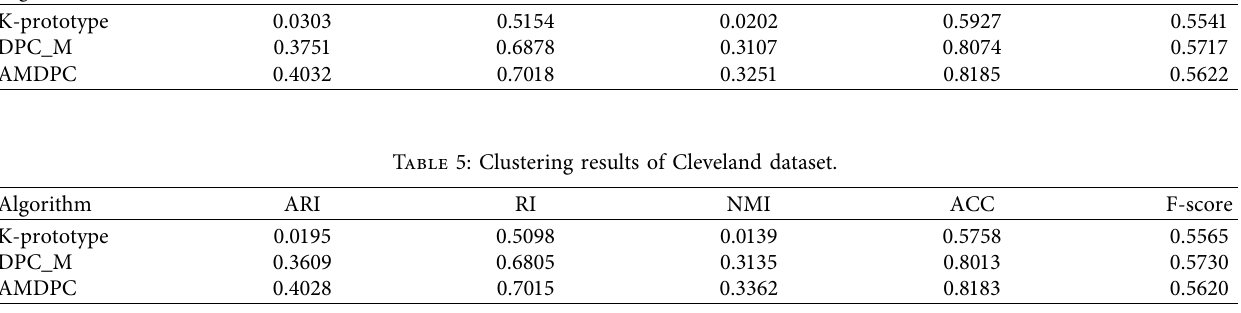
influence on the clustering effect, whereas the AMDPC algorithm automatically determined the center point of the clustering, and the algorithm ran more stably. The decision